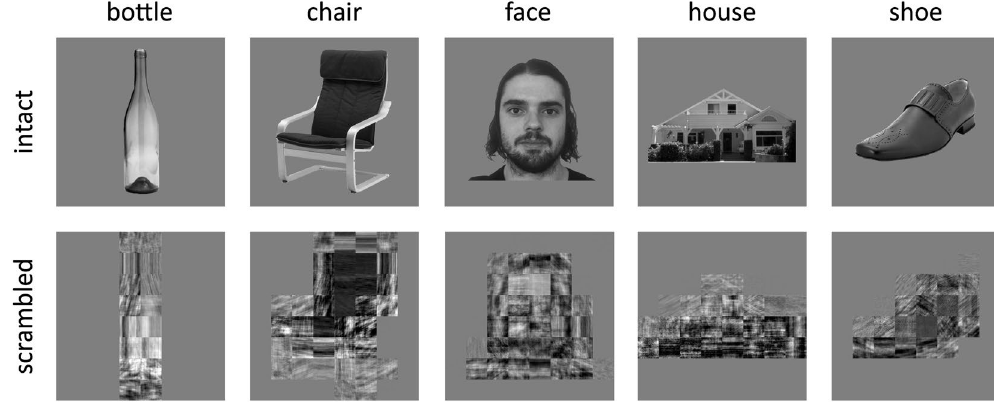
Figure 1. Exemplars of intact and scrambled images from the different object